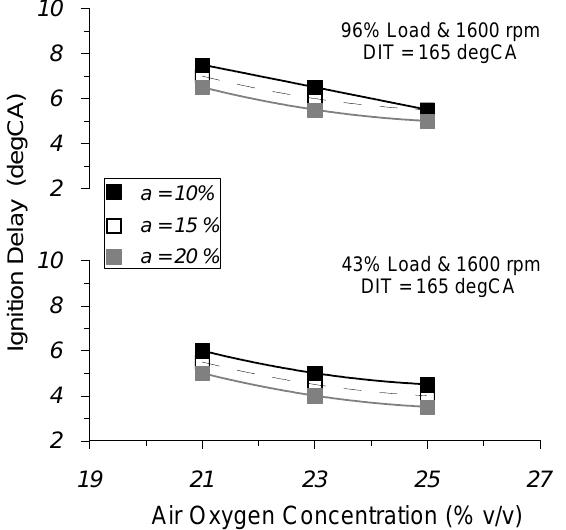
Figure 9. Calculated Ignition delay period versus “inlet-air oxygen ratio” for various “diesel fuel quantity ratios”, at 43% and 96% of engine rated load and 1600 rpm engine speed, for DIT = 165